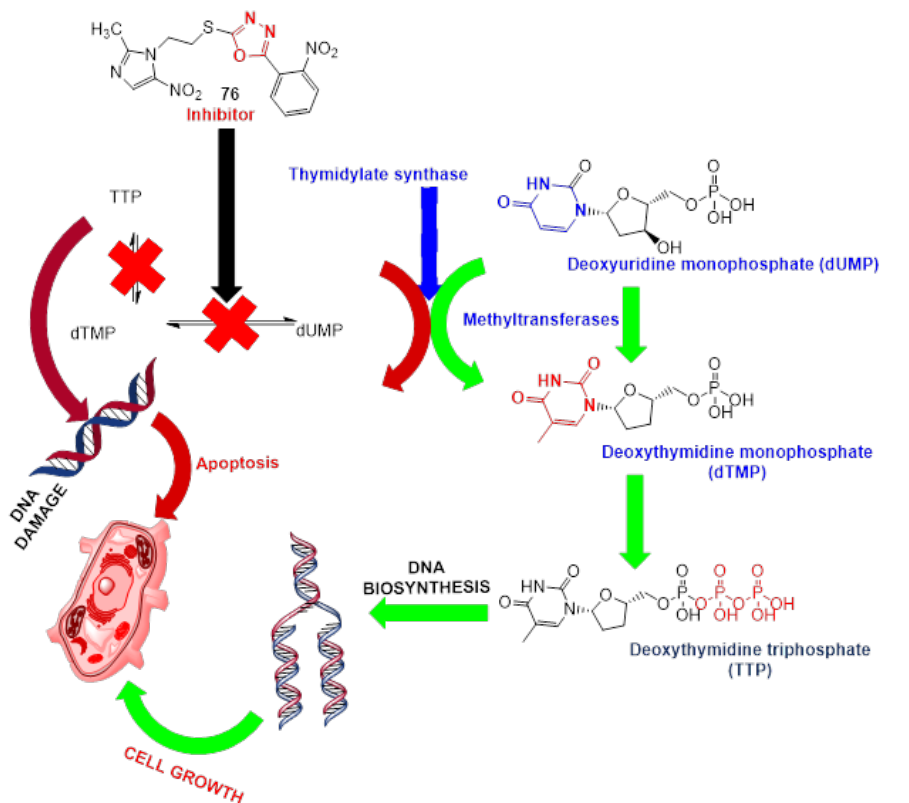
Figure 20. Thymidylate synthase and its inhibitors.